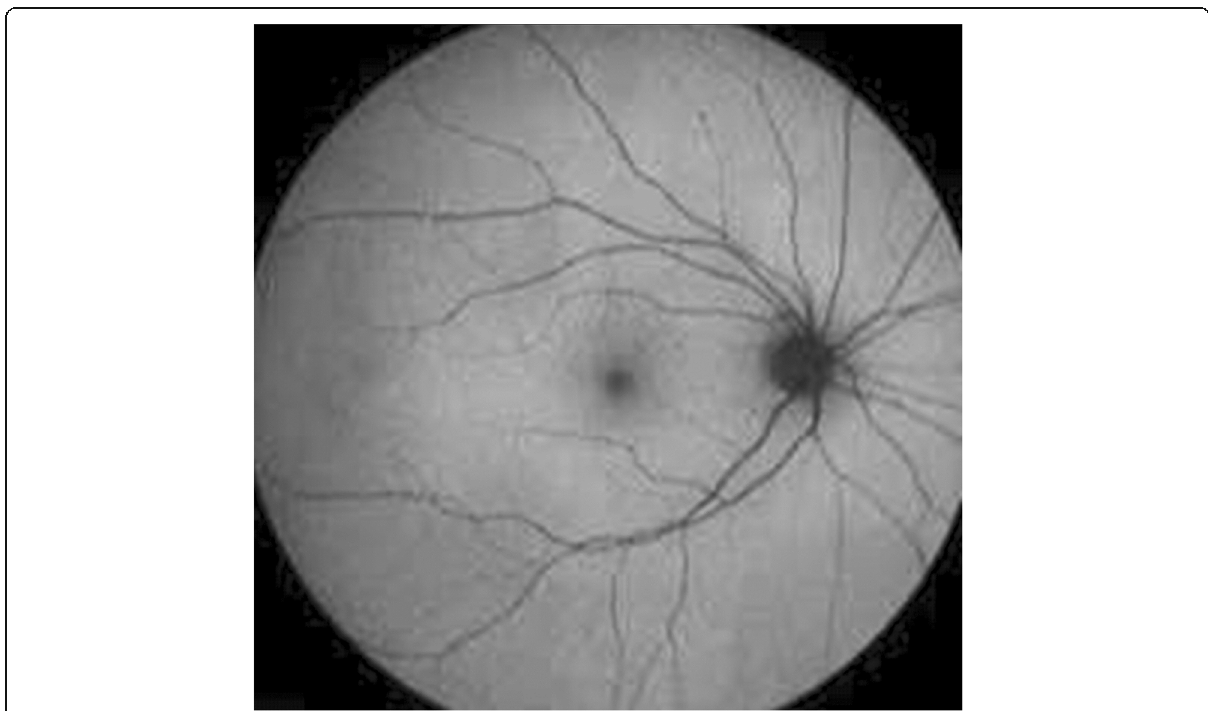
Fig. 1 Normal fundus autoflourscent